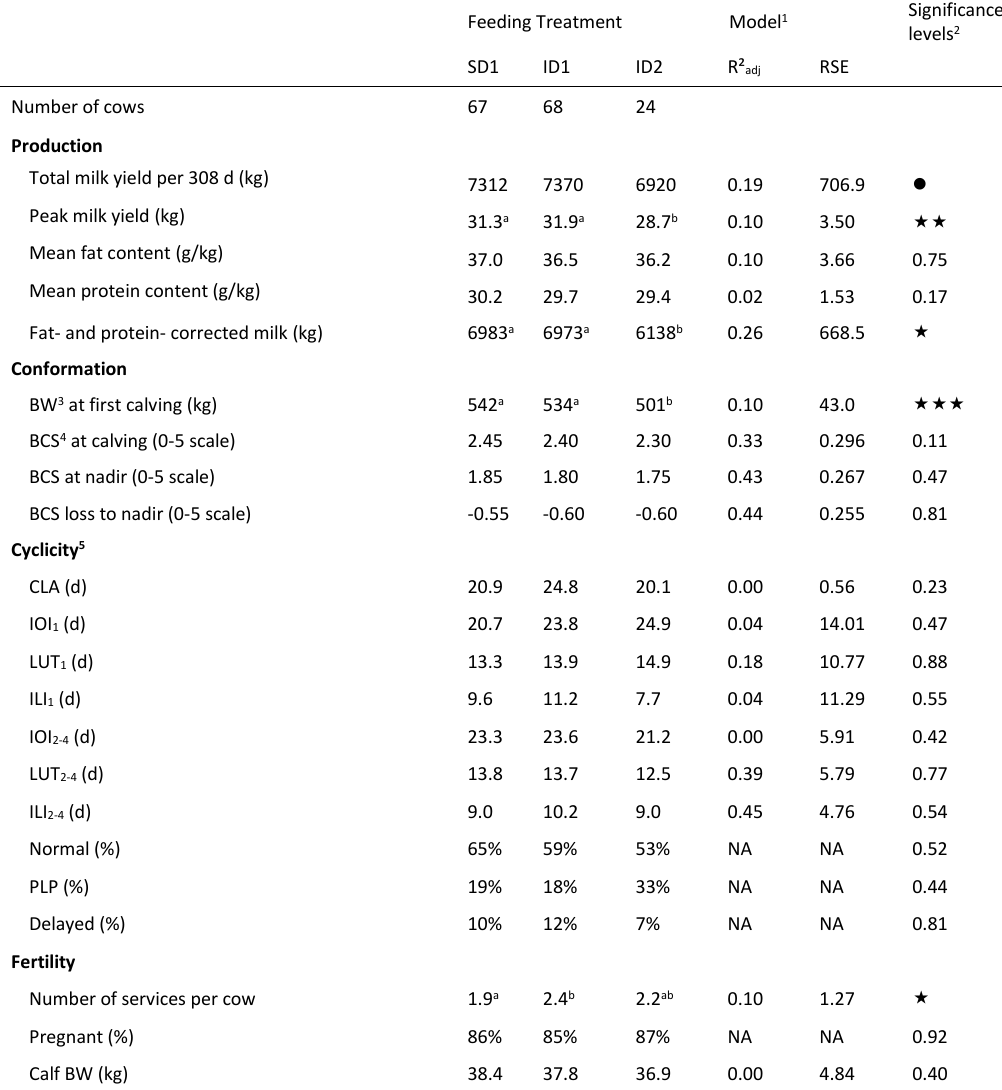
Table 5. Effects of feeding treatment during the rearing period on productive and reproductive performances of primiparous cows Feeding